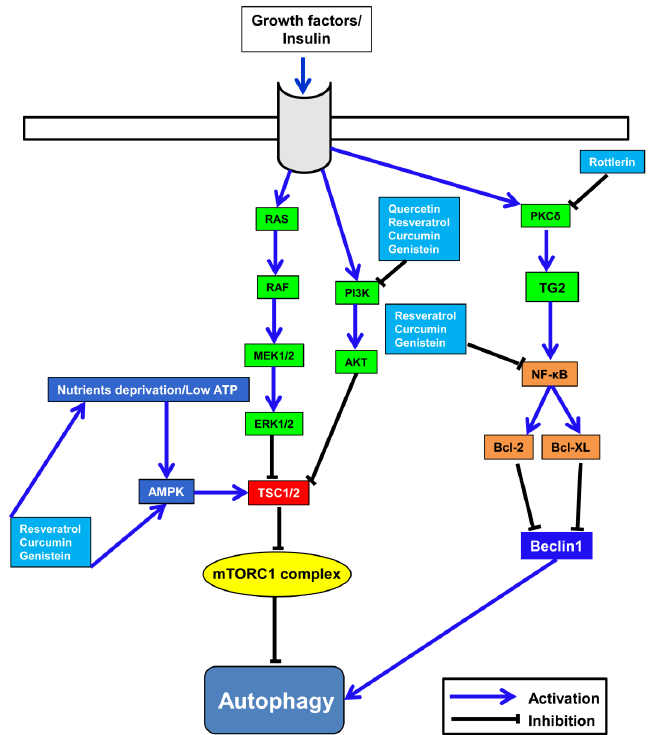
Figure 4. Role of polyphenols in the modulation of autophagy in breast cancer. Polyphenols modulate the autophagy process by regulating various signaling pathways, such as the PI3K/AKT, RAS/RAF/ERK, PKC δ , and AMPK signaling pathways.